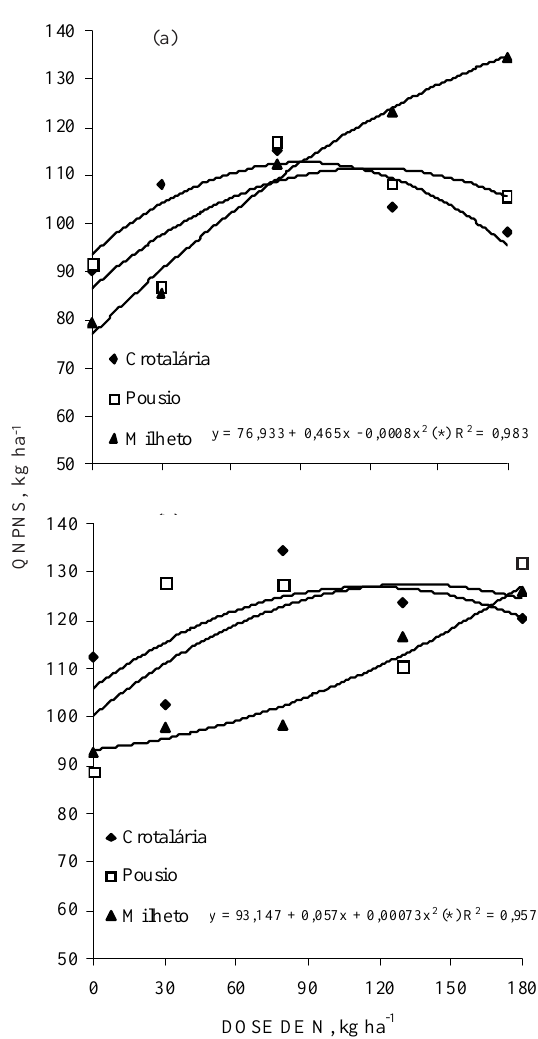
Figura 3. Quantidade de N na planta de milho (palha e grãos) nativo do solo (QNPNS), considerando as doses de N aplicadas no estádio de quatro ou oito folhas e sistemas de cobertura do solo, anos agrícolas 2001/02 (a) e 2002/03 (b). (* significativo a 5 % pelo teste